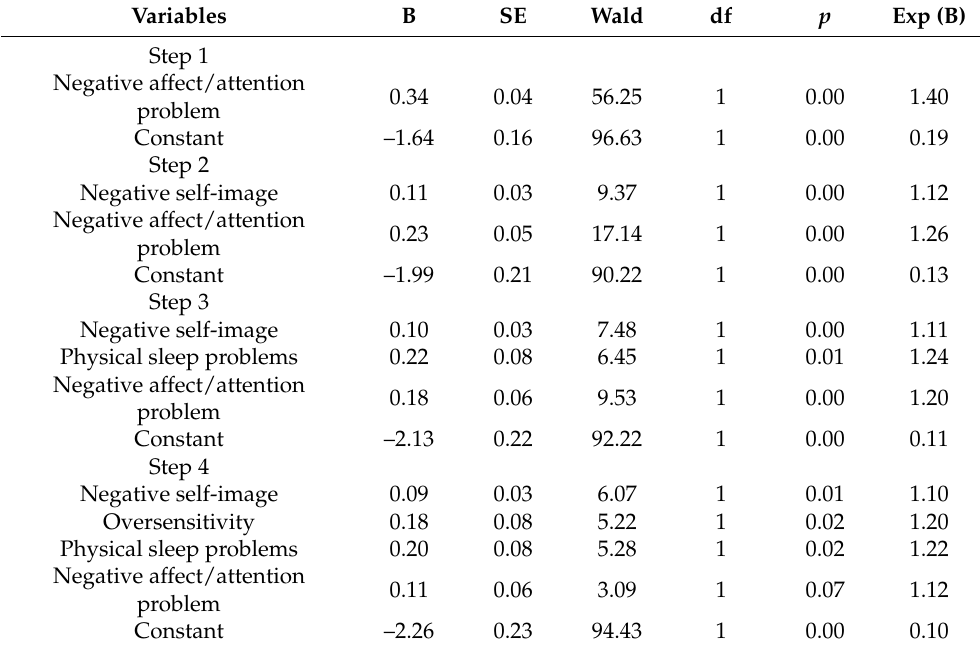
Table 7. Binomial logistic regression analysis for variables predicting self-injurious